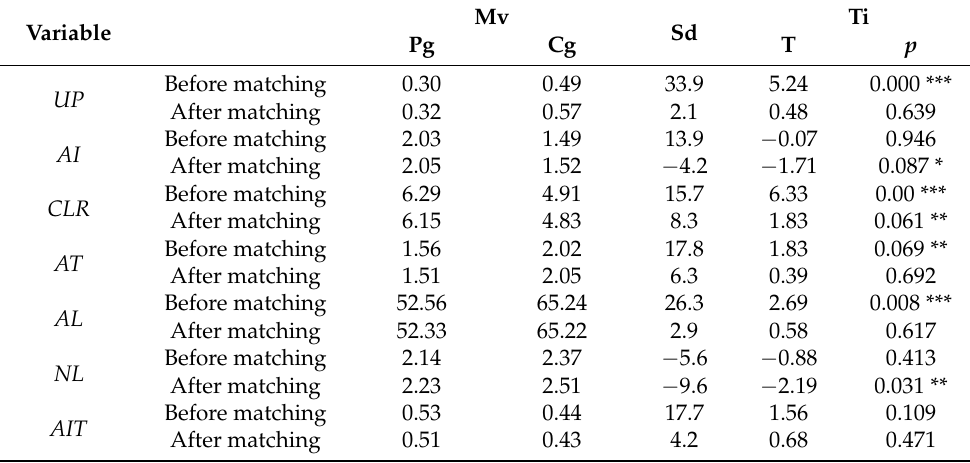
Table 3. Balance test results of the treatment group and control